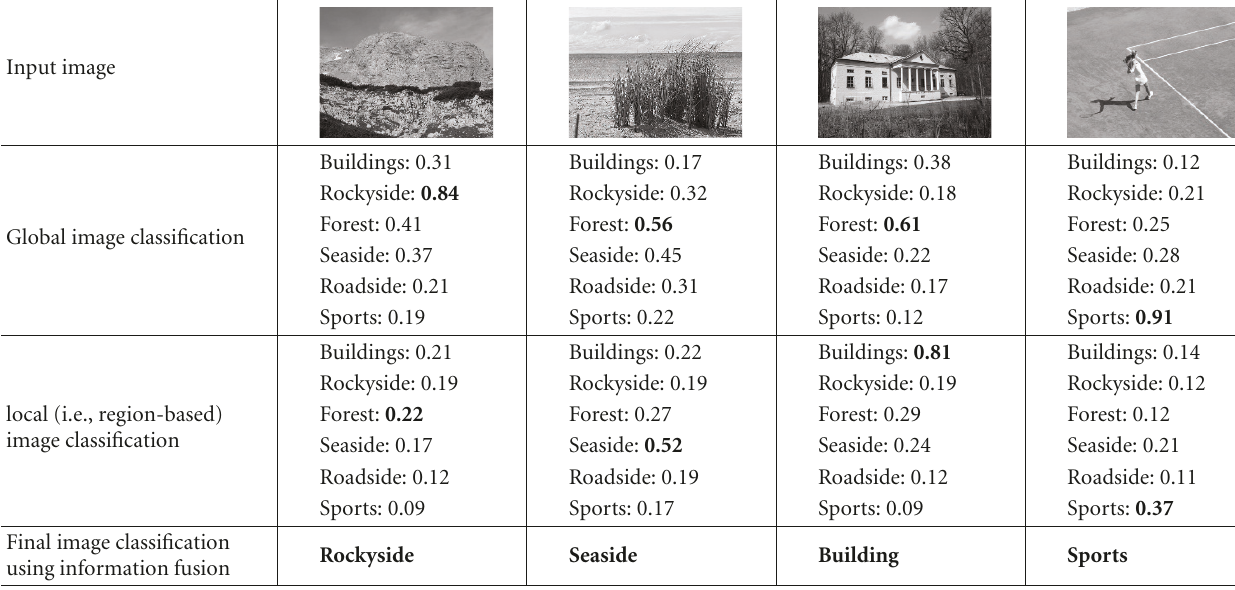
Figure 6: Indicative image-subdomain association results.